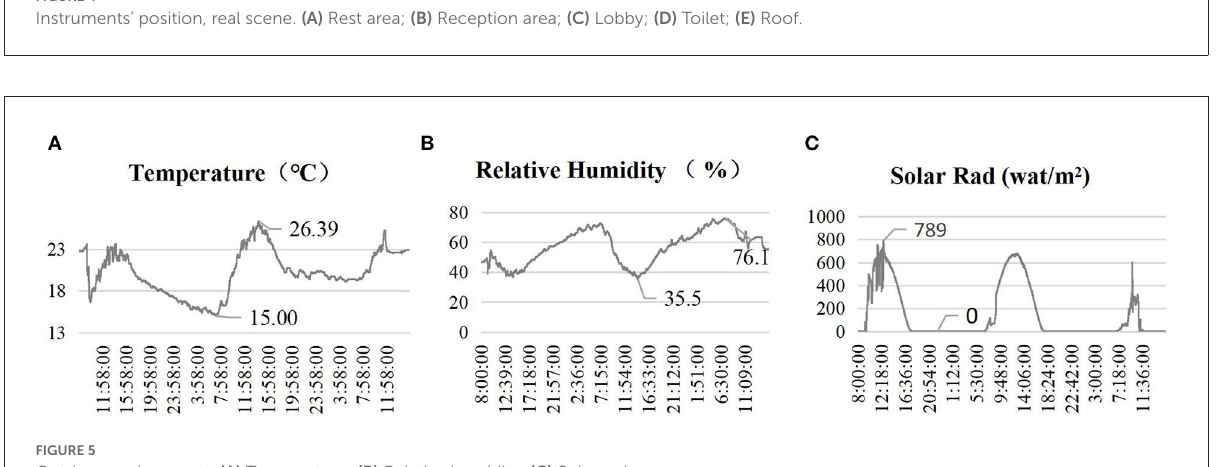
Measuring instrument: HOBO-MX2301A Measuring instrument: HOBO-MX1104A Measurement Measurement Measurement Measurement Measurement Measurement point 1 point 2 point 3 point a point b point